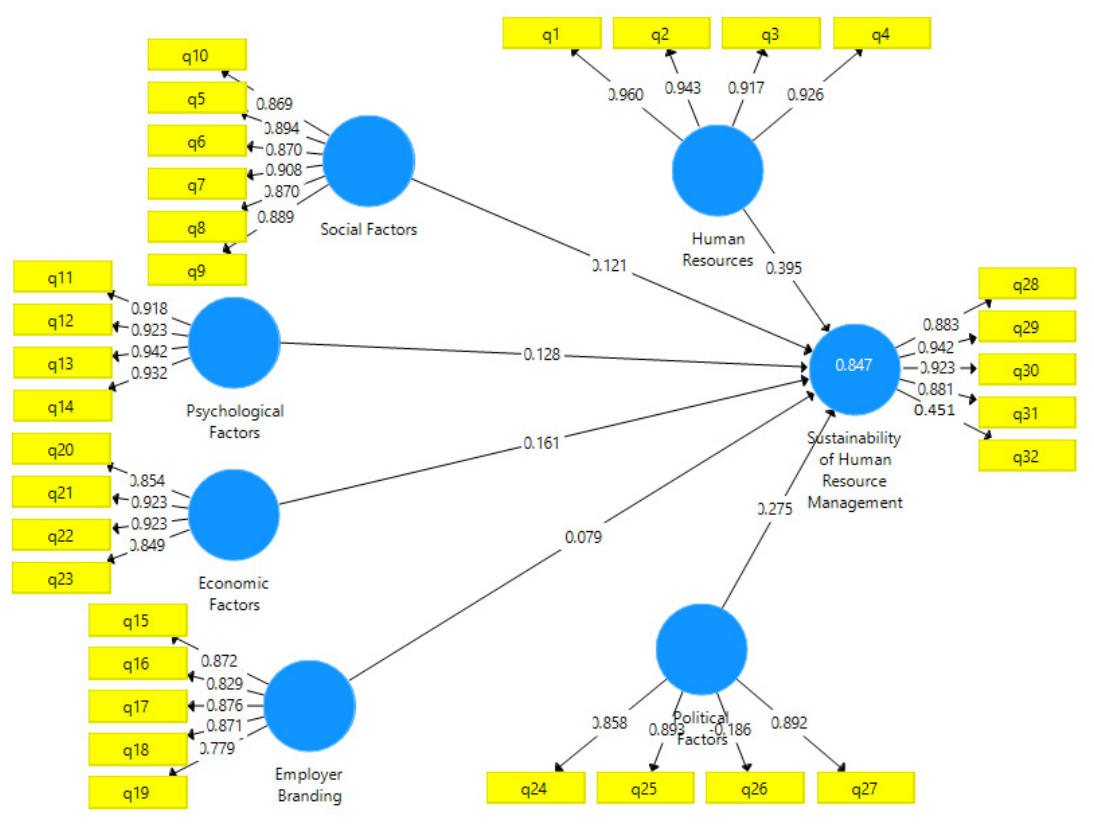
Figure 3. R 2 (Source: authors).